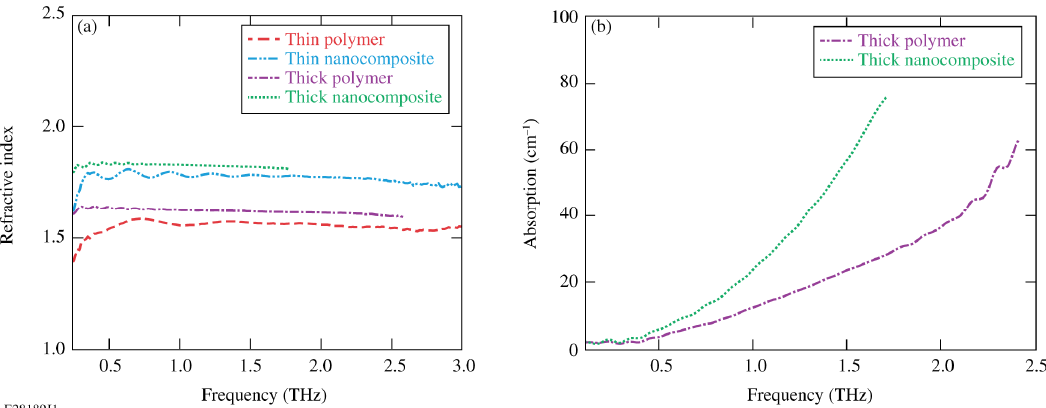
Figure 6. ( a ) Index of refraction and ( b ) absorption spectra for the tested neat copolymer and 1-wt% graphene nanocomposite samples. Note: The thin sample consisted of PET-DLA 4060 copolymer, while the thick one consisted of PET-DLA 6040. The data points were trimmed according to sample bandwidth (see Figure 5b).